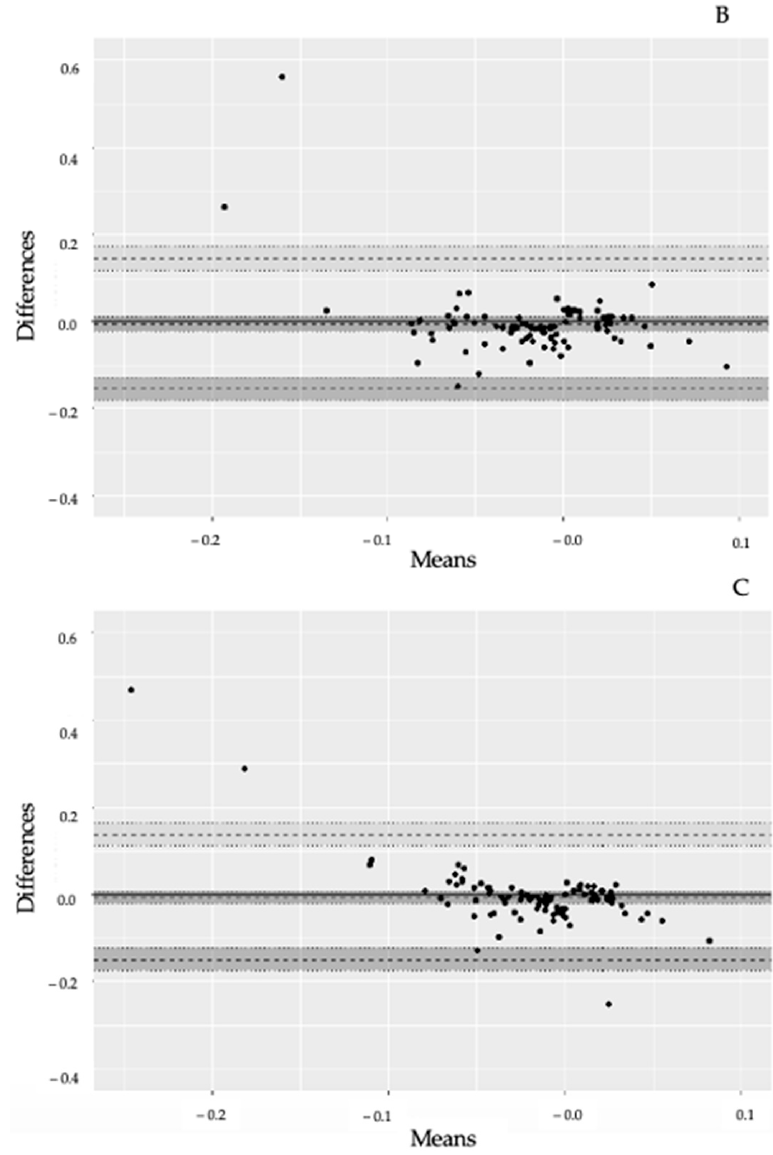
Figure 3. ( A ): Bland–Altman plot of II-lead and single-lead ECG results. Comparison of lead II from a 12-lead ECG versus a single-lead ECG on the anterolateral left chest. Limit of agreement = LoA Upper dotted line = upper LoA, lower dotted line = lower LoA. Dotted line in the middle = mean difference. Dark area around dotted lines = 95% confidence intervals (95% CI). Mean difference = − 0.019 mV (95% CI: − 0.030 to − 0.009). Upper LoA = 0.082 mV (95% CI 0.064 to 0.100) and lower LoA = − 0.121 mV (95% CI: − 0.139 to − 0.103). ( B ): Bland–Altman plot of V5-lead and single-lead ECG results. Compari- son of lead V5 from a 12-lead ECG versus a single-lead ECG on the anterolateral left chest. Dotted line in the middle = mean difference. Limit of agreement = LoA. Upper dotted line = upper LoA, lower dotted line = lower LoA. Dark area around dotted lines = 95% confidence intervals (95% CI). Mean difference − 0.005 mV (95% CI − 0.021 to 0.010). Upper LoA 0.145 mV (95% CI: 0.118 to 0.172) and lower LoA − 0.155 mV (95% CI: − 0.182 to − 0.128). ( C ): Bland–Altman plot of V6-lead and single-lead ECG results. Comparison of lead V6 from a 12-lead ECG versus a single-lead ECG on the anterolateral left chest. Limit of agreement = LoA Upper dotted line = upper LoA, lower dotted line = lower LoA. Dotted line in the middle = mean difference. Dark area around dotted lines = 95% confidence intervals (95% CI). Mean diff − 0.006 mV (95% CI − 0.021, 0.010). Upper LoA 0.138 (95% CI: 0.112; 0.164) and lower LoA − 0.149 (95% CI − 0.175; −